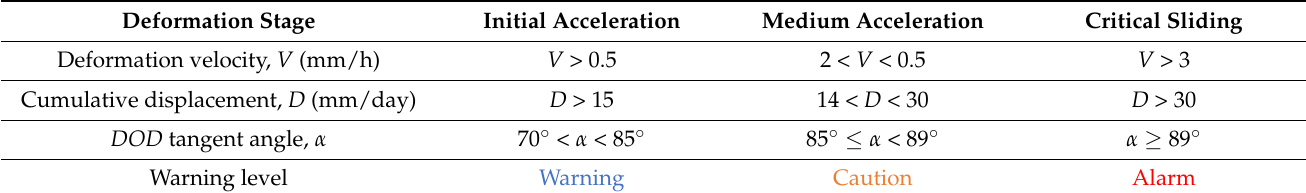
Figure 14. DOD tangent angle. Table 1. Comprehensive early warning criterion at an accelerated stage. Table 1. Comprehensive early warning criterion at an accelerated stage.